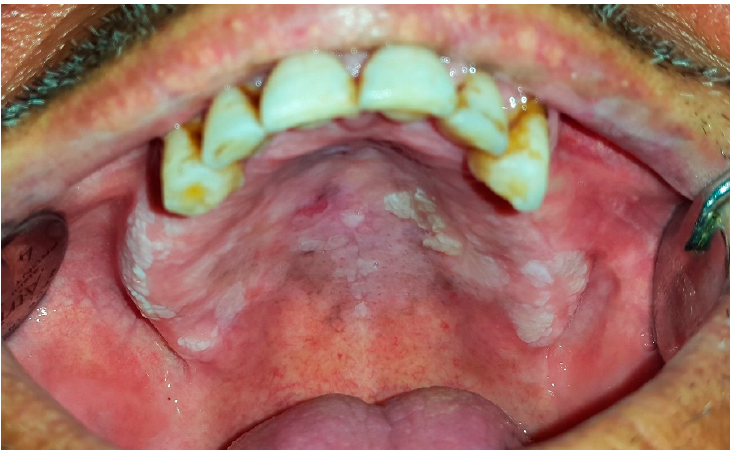
Figure 10. Proliferative verrucous leukoplakia spreading over hard palate and alveolar